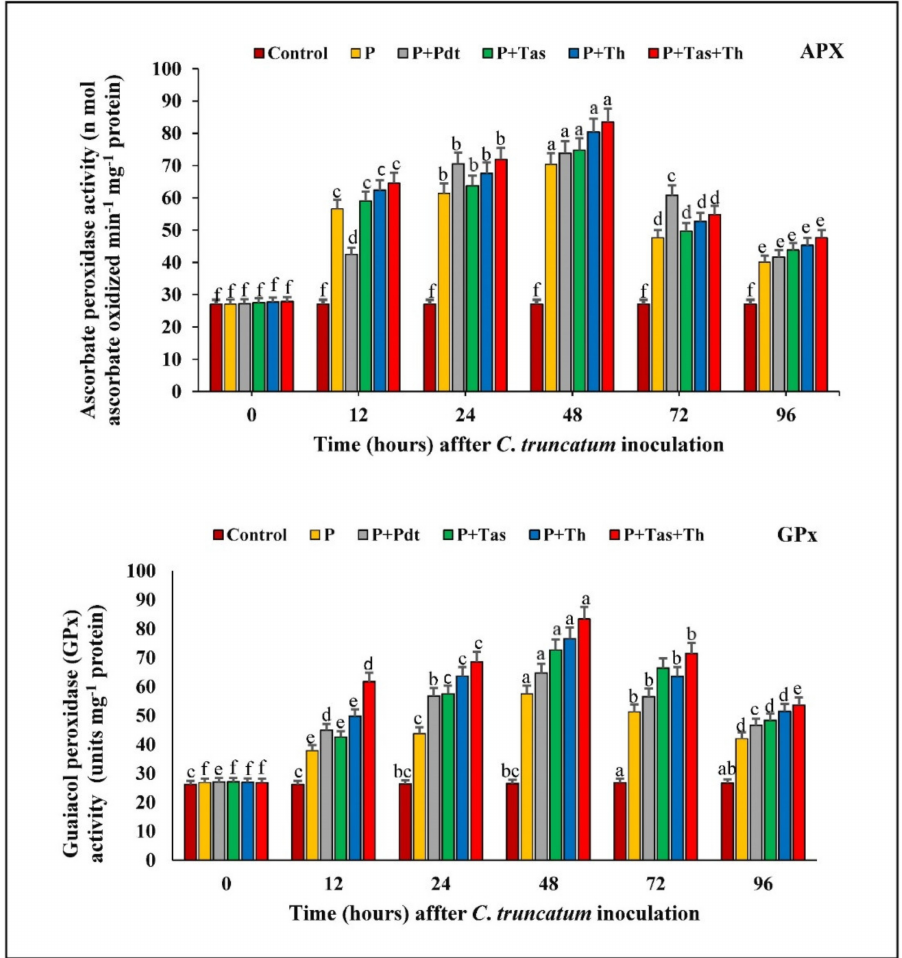
Figure 13. The effect of bioagents (Pdt = P. dendritiformis, Tas = T. asperellum, Th = T. harzianum, and Tas+Th = T. asperellum + T. harzianum ) on the accumulation of antioxidative enzymes (APx and GPx) either individually or in the combination of treatment in chilli seeds under a challenged condition and C. truncatum -infected samples. Each value is expressed as the mean of triplicates, and the bars sharing the same alphabetical letters are not significantly different ( p ≤ 0.05) using Duncan’s multiple range test. The vertical bar designates the standard